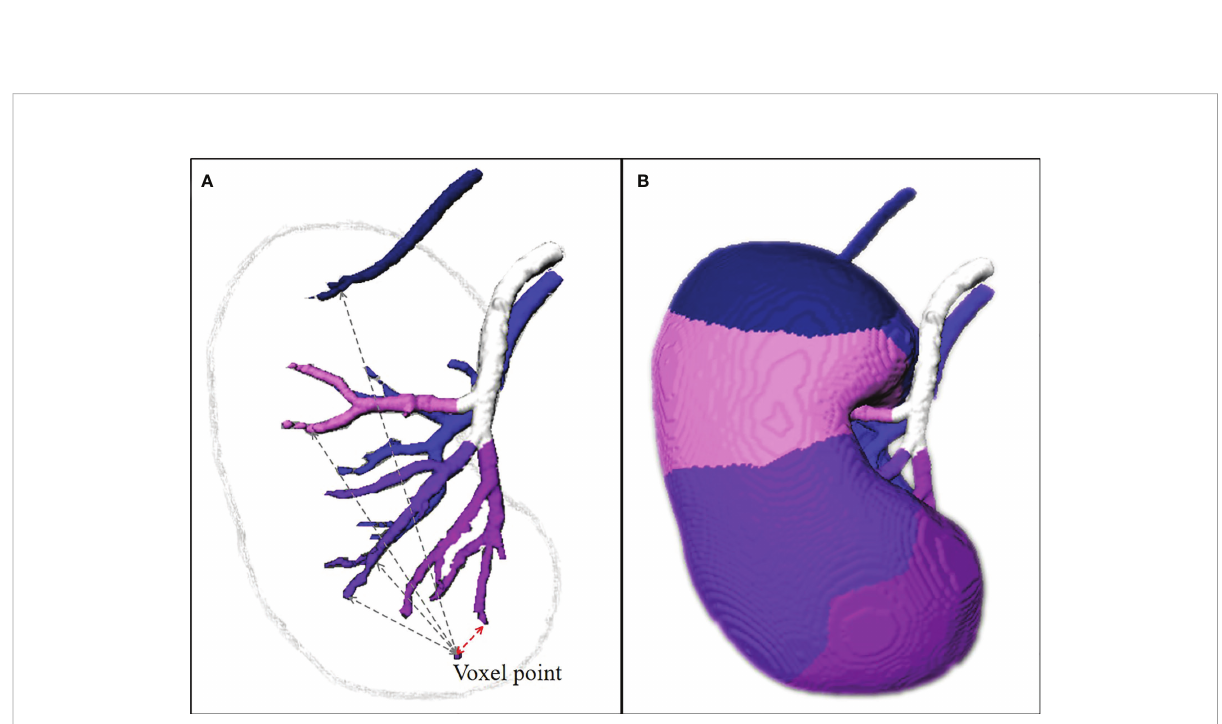
FIGURE 3 The estimation of perfusion regions. (A) The lobar arteries and their branches are extracted, set to the same category and marked with the same color if they branch out from the same segmental arteries. The distance transformation algorithm is used to fi nd the closest lobar arteries or their branches for every voxel point in the renal parenchyma as its blood supply vessel, and the color of this point is marked. (B) All voxel points in the renal parenchyma are categorized according to their colors, and the perfusion regions of different segmental arteries are then depicted. The TKP model is fi nally